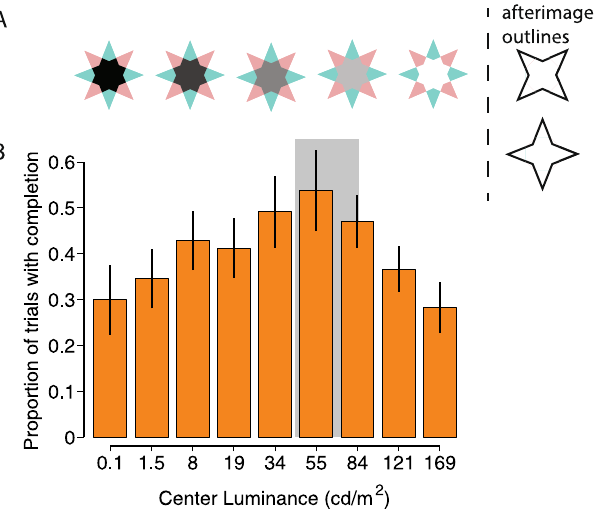
Figure 1. ( A ) Example stimuli, with on the right the two outlines that were shown during the time the afterimage was visible. ( B ) Mean ( ± s.e.m. over subjects) proportion of trials with afterimage completion dependent on the luminance level of the star ’ s center. The gray shaded area corresponds to the values that are approximately consistent with